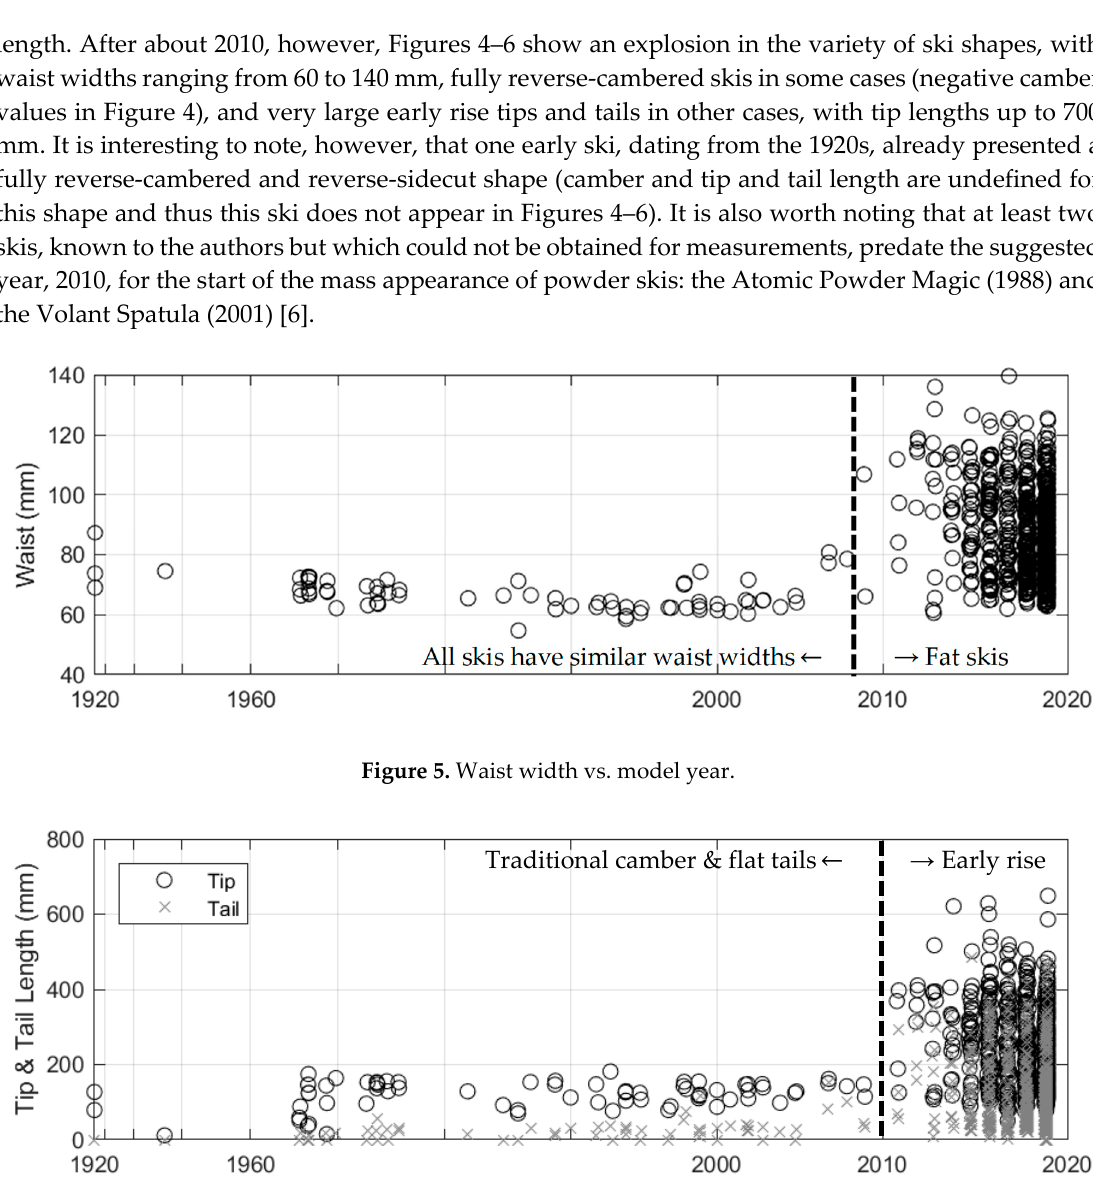
Figure 6. Tip and tail lengths vs. model